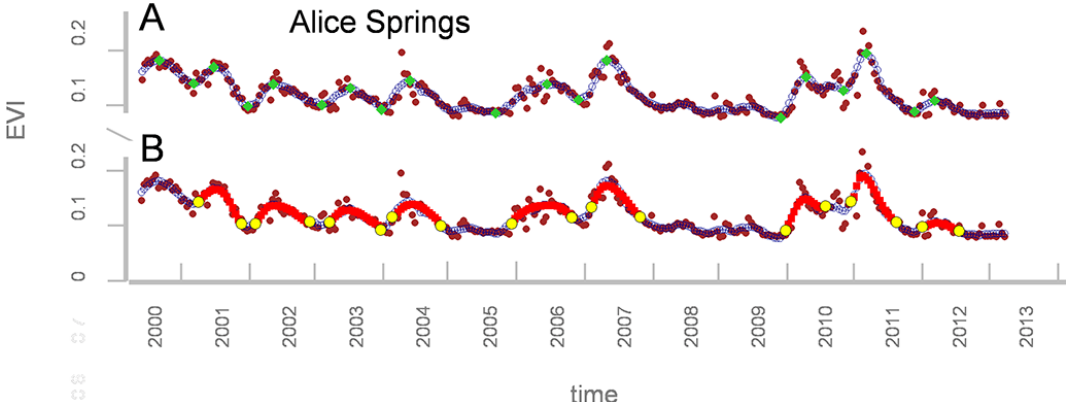
Figure 2. Algorithm steps applied to the 14-year MODIS EVI time series (MOD13C2 single 5.6km pixel) for the Alice Springs flux site, representing semi-arid mulga ( Acacia ) woodland of the center of Australia. (a) EVI time series after screening out low-quality observations (brown circles), EVI time series after gap filling and smoothing (blue circles), and flagged minimum and peak-of-cycle points (green dia- monds). (b) Curves fitted as seven-parameter double logistic functions (red squares) characterizing the phenological cycles, and identifying start- and end-of-cycle points (yellow circles) delineating the cycles. The timing, length, amplitude, and magnitudes of the phenological cycles at the site vary